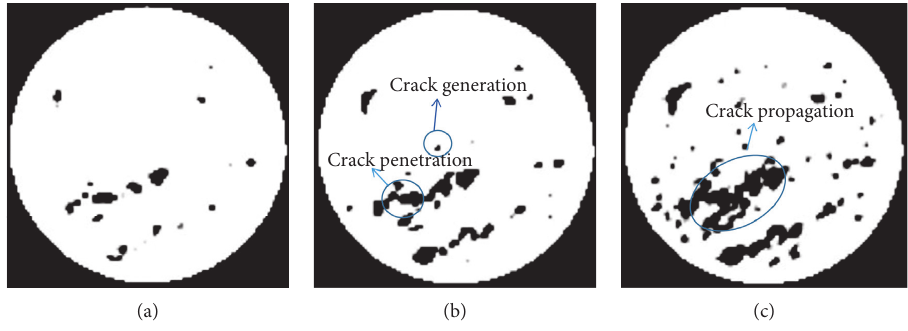
Figure 11: Degradation of the mesostructure of fine sandstone A1.